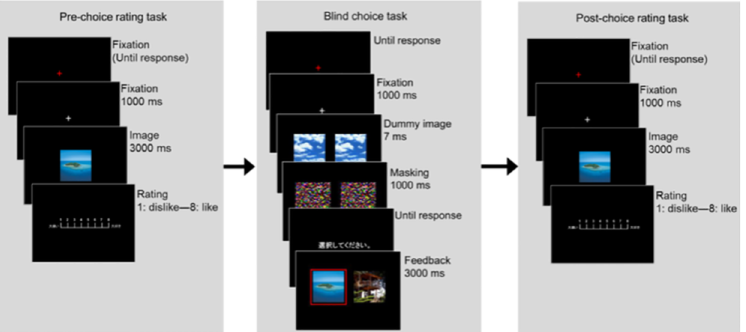
Fig 2. Experimental tasks. Experimentaltasks constructed in three sessions: Pre-choicerating task, Blind choice task, and Post-choice rating task. In the Pre-choicerating task, participants were presented items for 3 s. They rated their preference for it on an eight-pointscale. In the blind choice task, participants were instructed that two images that were rated in the pre-choice rating task were presentedsubliminally. Of the two images, they were asked to choose the one which they preferred. In fact, however,two identicaldummy images were presentedfor 7 ms. After the choices were made, the two images were presented. The red rectangle denotes that it was chosen blindly. In the post-choice rating task, participantswere presentedthe same image stimuli as those of the pre-choicerating task. Their preference was rated again.